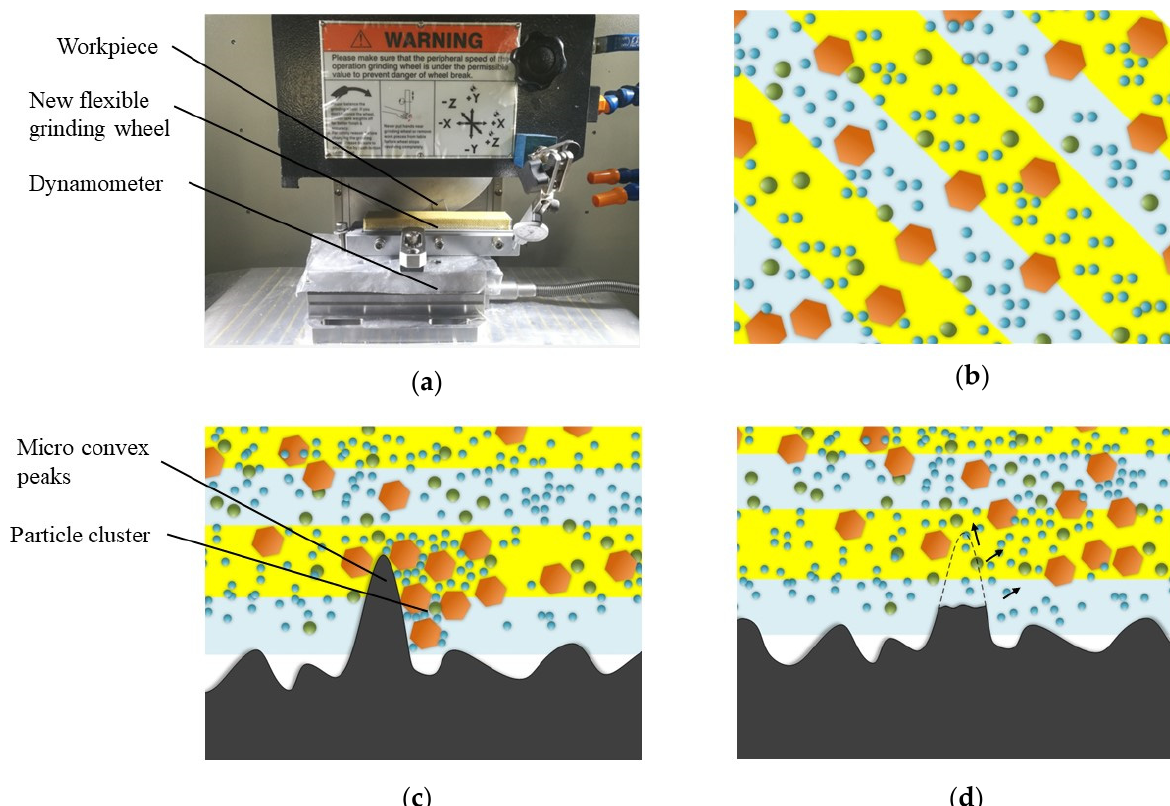
Figure 3. The processing principle of the high-shear low-pressure flexible grinding wheel. ( a ) Experimental setup. ( b ) High-shear low-pressure flexible abrasive grinding wheel in balanced state. ( c ) High-shear low- pressure flexible grinding wheel contact the workpiece and cluster effect occurs. ( d ) The micro-convex peaks are removed and return to the initial state.